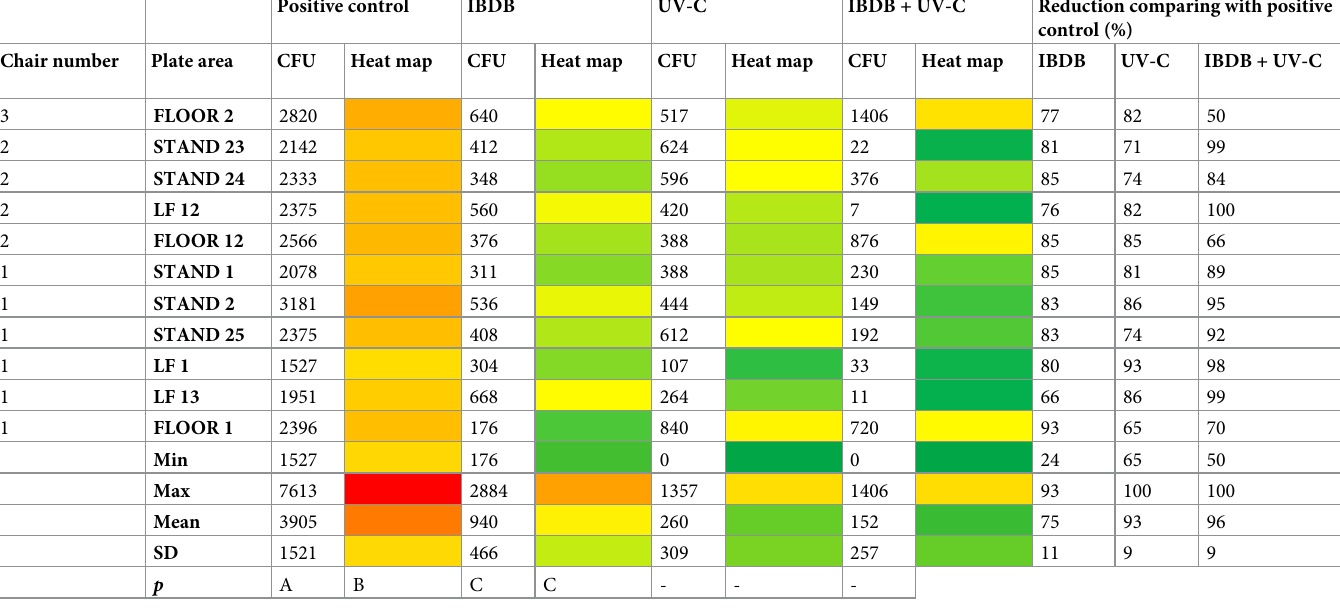
(Fig 2A). For the group (IBBD), the minimum value was 176 and maximum 2884, with an average of 940 (466) CFU (Fig 2B), while in the UV-C group the minimum value was 0 and maximum of 1357, with an average of 260 (309) CFU (Fig 2C), and minimum 0 and maxi- mum1406 in the IBBD+UV-C group, with an average of 152 (257) CFU (Fig 2D). The mean difference between the control group and the IBBD group was, on average, 75%. When using UV-C technology, average CFU counts had, on average, a 93% and 96% reduction in IBBD +UV-C. In the analysis of variance, a significant difference was observed between the group without barriers and the other experimental groups (F (3,220) = 258.3, p = < 0.0001). In addi- tion, post hoc analysis using Tukey’s multiple comparation criterion for significance indicated statistical difference between the IBBD and UV-C groups (p < 0.0001) and there was no statis- tically significant difference between the UV-C and IBBD+UV-C groups (p > 0.05). To evaluate the distance that PCDP can reach from the generating source, new Petri dishes were posi- tioned in the corridor that connect the clinics to the end of the group test without barriers. As shown in Fig 2E, it was observed the growth of 903 (28) CFU in the plates positioned 1m from the input (yellow box), 3044 (64) CFU at 5m distance (dark orange box) and 1966 (42) CFU 10 m away from the generating source (light orange box). Schematic 3D data are presented in S5 Fig. Fig 3 shows the sedimentation time in the environments of the control group and the IBBD + UV-C group. After 30 minutes of activation of the dental drill containing L . casei , in the group without barriers the mean CFU was 3167 (435) CFU, while for the IBBD + UV-C group it was 5 (2) CFU (p < 0.0001). After 60 minutes of activation, the mean suspended CFU that was deposited on the MRS board was 441 (13) in the group without barrier and 1(0) in the IBBD + UV-C group (p < 0.0001). At 90 minutes after activation, the mean CFU of the